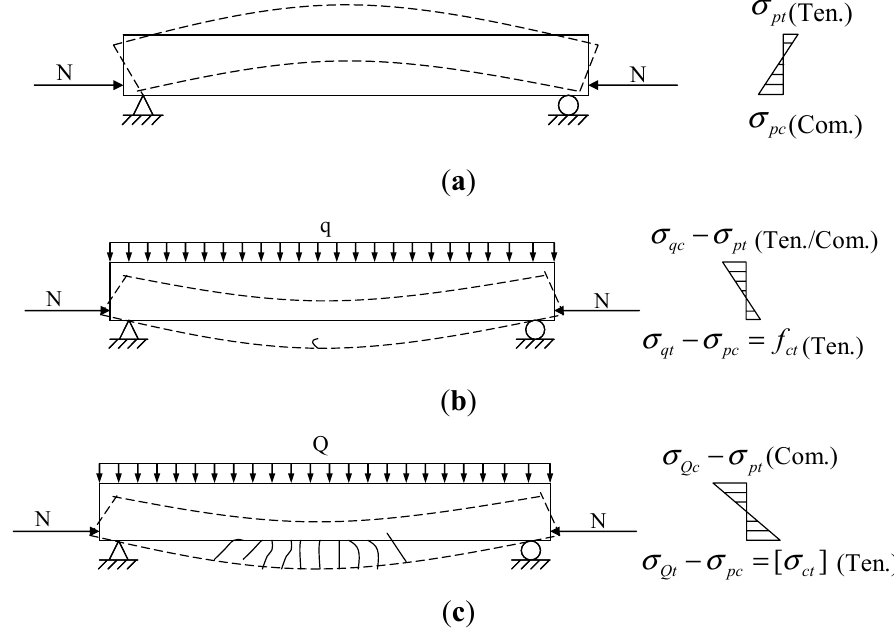
Figure 1. Stress analysis of RC simple supported beam. ( a ) Prestress construction; ( b) Initial cracking; ( c ) Normal service